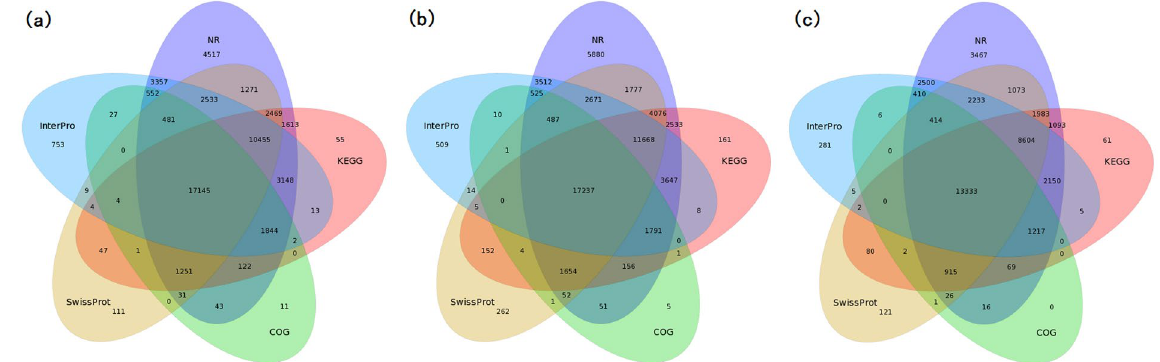
Figure 2. The Venn diagram of unigenes annotation from five public protein databases (The colors severally denote NR, SwissProt, KEGG, InterPro, COG databases). ( a ) Lithospermum erythrorhizon , ( b ) Arnebia euchroma , ( c ) Echium plantagineum .